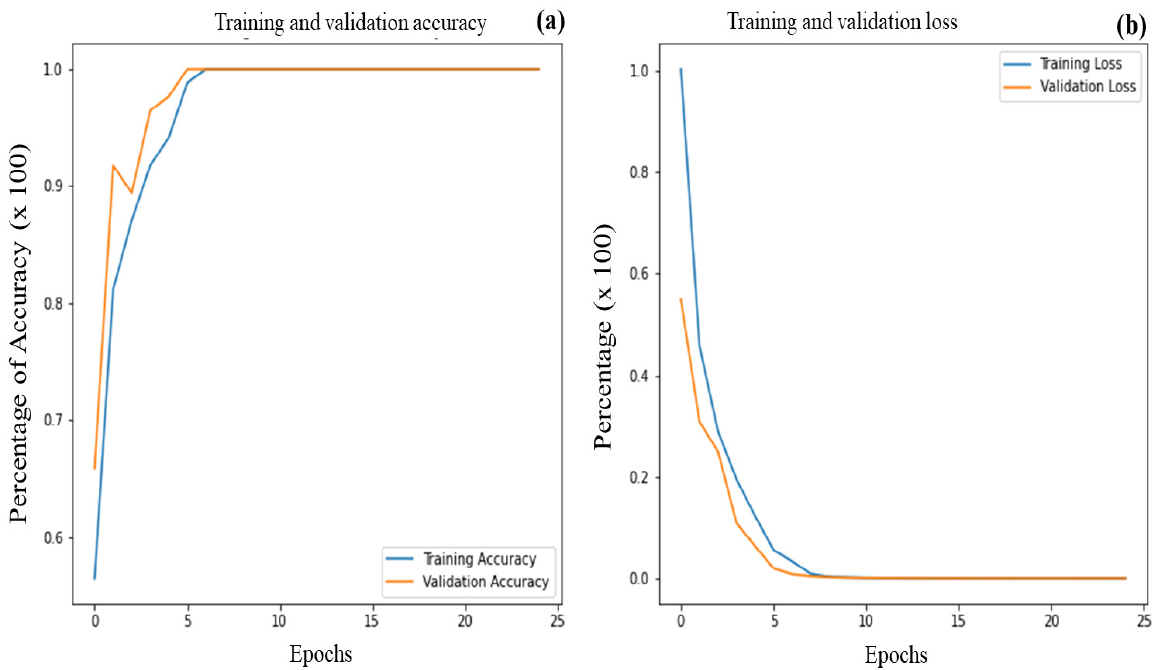
Figure 17. ( a ) Accuracy and ( b ) validation loss for multi (12)-lead.